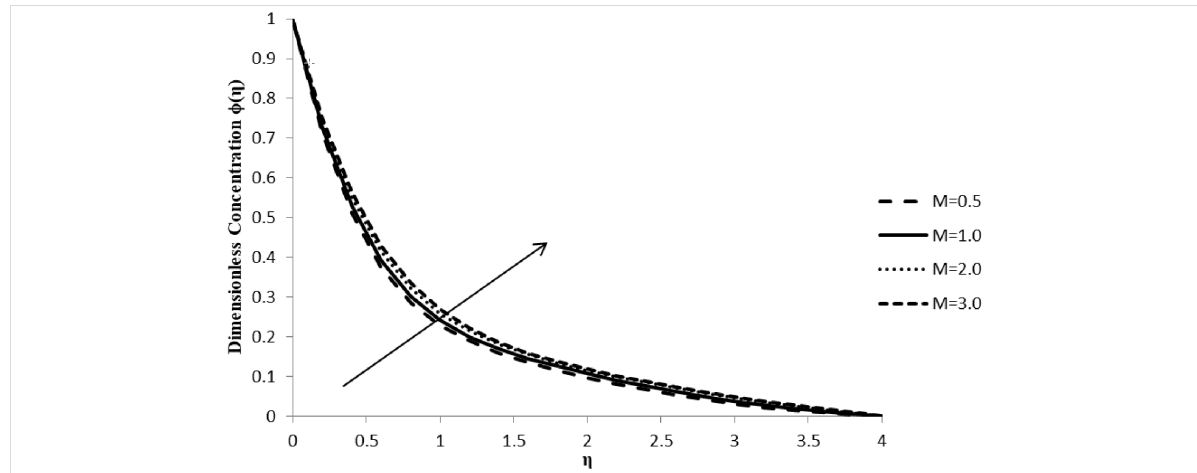
Figure 14: Influence of magnetic parameter M on the concentration distribution ϕ ( η ) when n = 2.0, Pr = 2.0, Nb = Nt = 0.5, Q = 0.0, Le = 5.0, ξ = 1.0, and F w = 0.2.